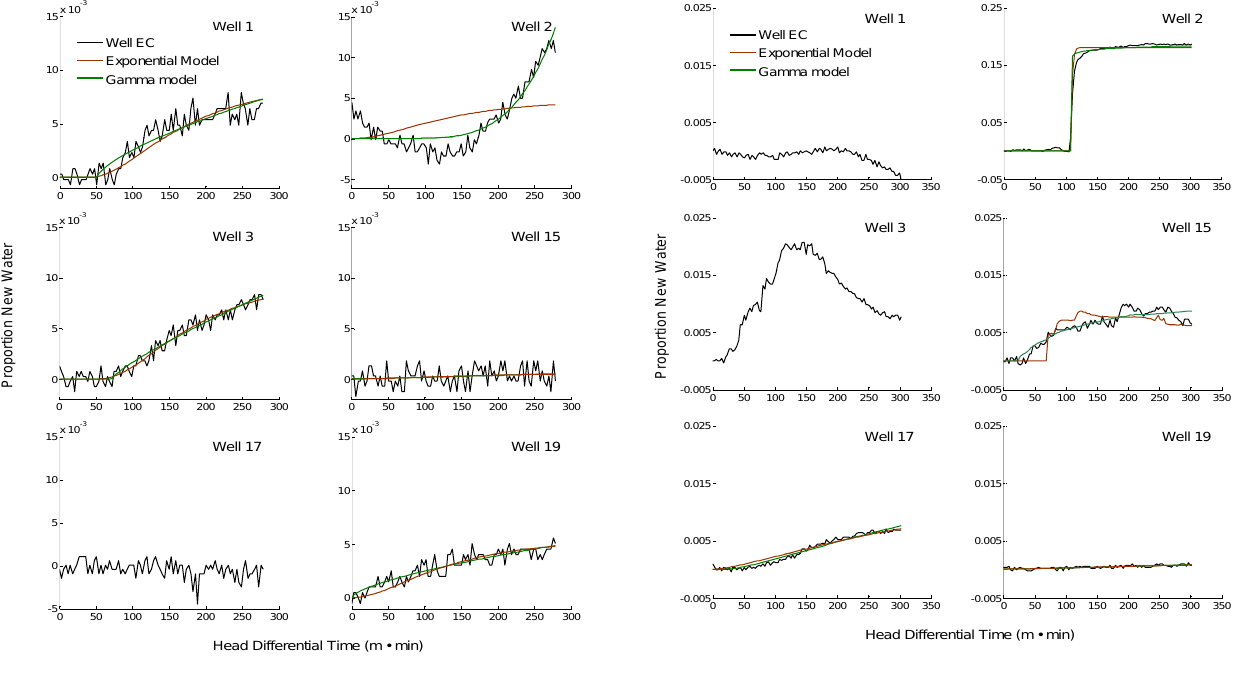
Fig. 7. Optimized models of EC truncated at the end of head differ- ential time for no-salt test. EC response in well 17 was not modeled.